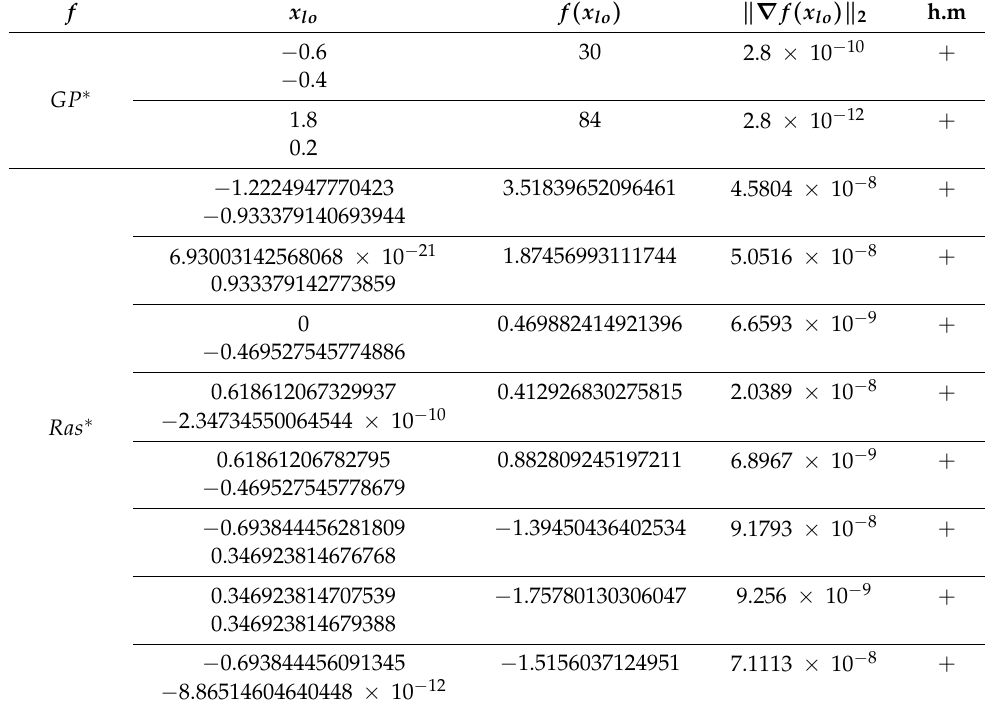
Table 2. Local minima and their function values of the second type found by GL